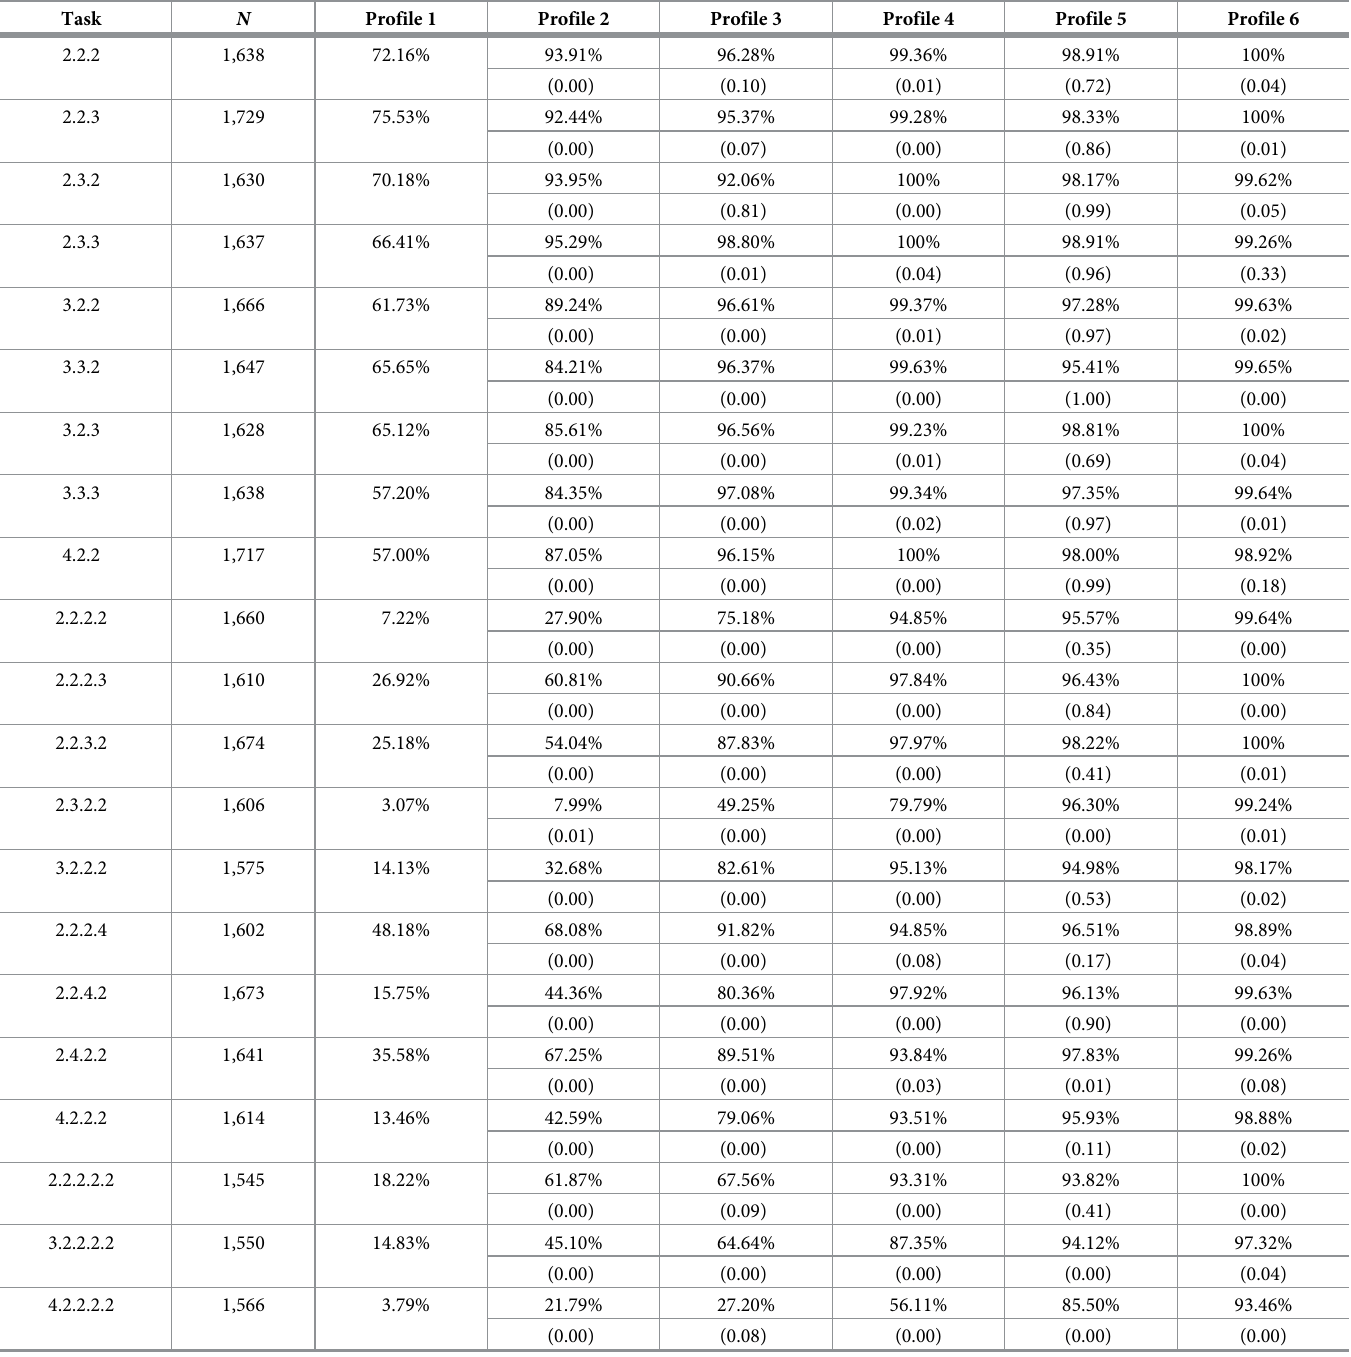
Table 3. Profiling with the 3- RRT 1 by 2- TT